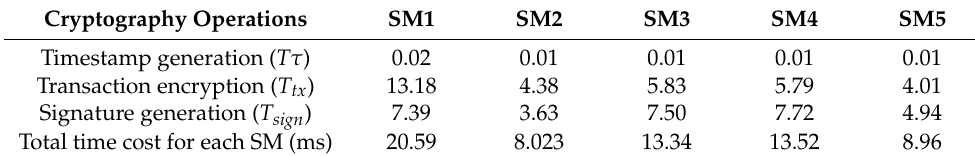
Table 3. Time cost analysis of each smart meter for half hourly energy consumption records.